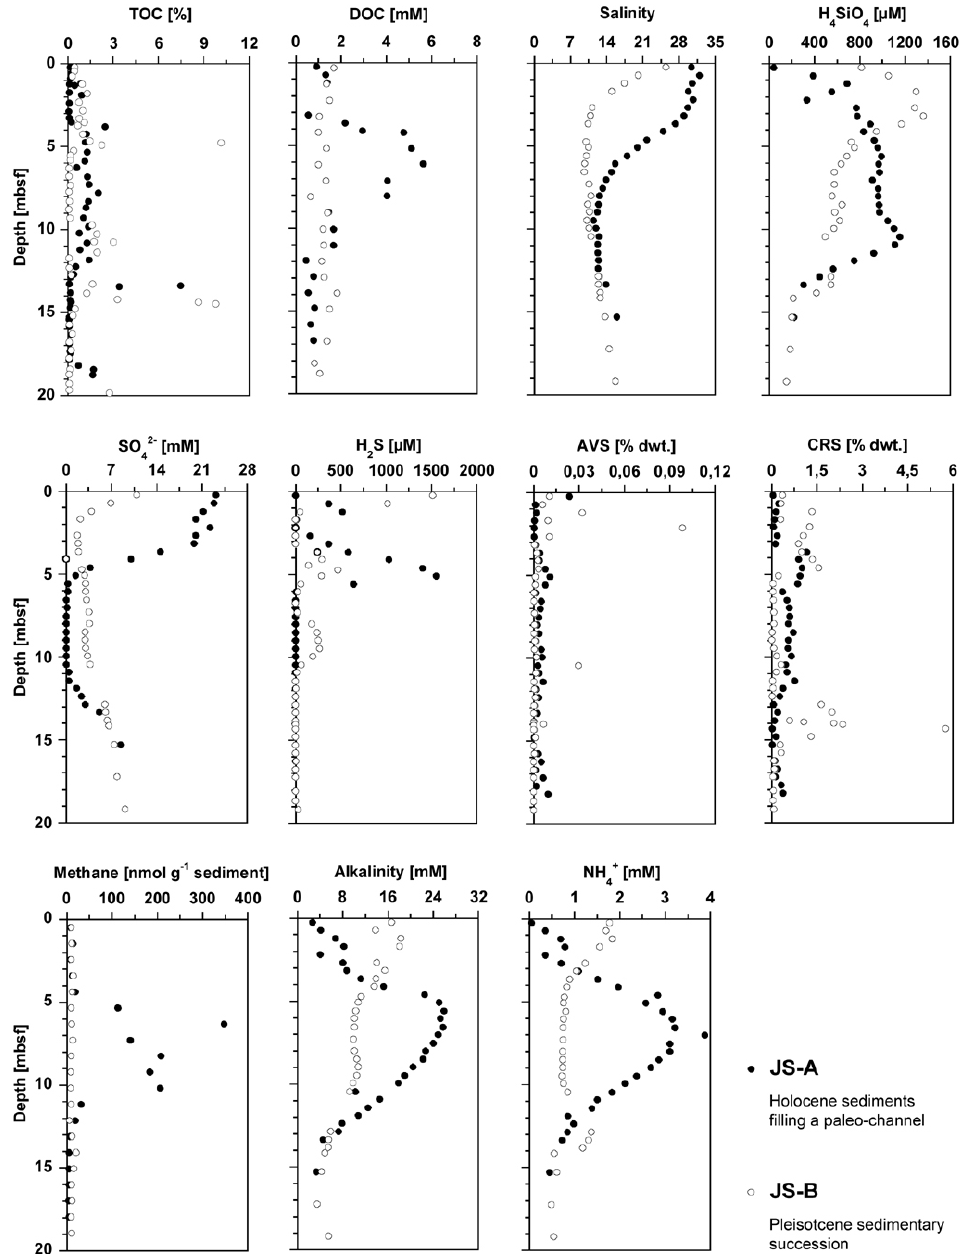
Fig. 3. Biogeochemistry at sites JS-A (filled circles) and JS-B (open circles) in the subsurface of the Janssand tidal flat: total organic carbon (TOC), dissolved organic carbon (DOC), salinity, silica, sulfate, sulfide, acid volatile sulfur (AVS), chromium reducible sulfur (CRS), methane, alkalinity, and